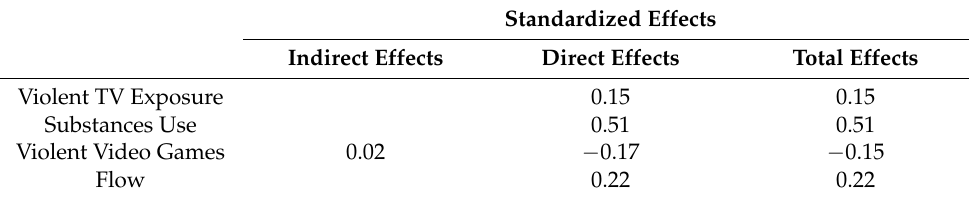
Figure 1. Predictive model of CPV towards mothers (final model). Rectangles represent observed variables and ovals represent latent variables. Values listed are standardized coefficients. * p < 0.05. *** p < 0.001. Table 3. Standardized effects of exposition to violence in TV, substance use, violent video games and engagement on CPV towards mothers (final